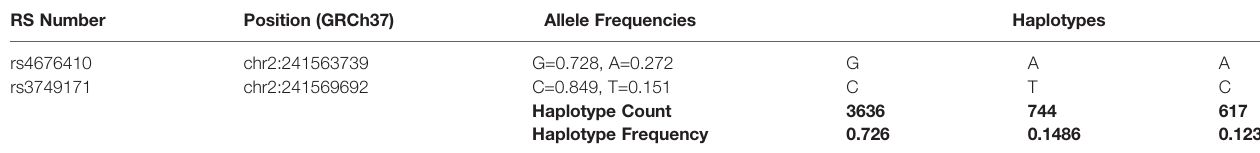
TABLE 3 | Haplotype frequencies of IBD-associated GPR35 variants across all populations analyzed by LDHap (ldlink.nci.nih.gov/?tab=ldhap).